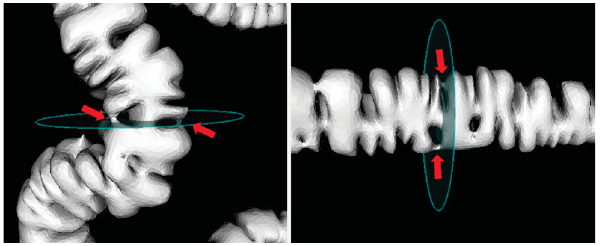
Fig. 10 Multiple components. The red arrows indicate two small handles. Our method is robust to topological noise. In this situation there may be locally more than one connected component in the cross-sectional plane. We keep the one closest to the centerline as the cross section in